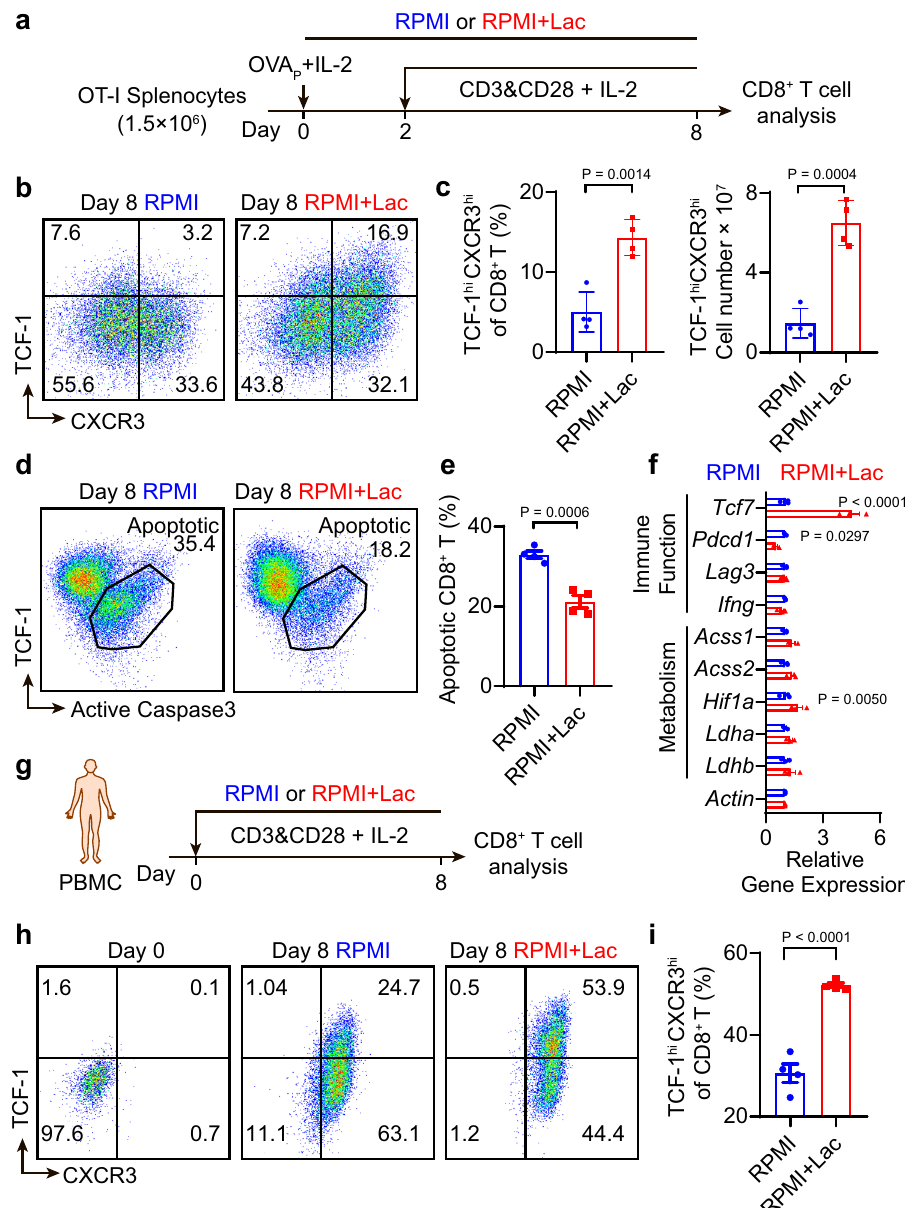
Fig.5|LactateincreasesTCF-1expressionandreducesapoptosisofCD8 +